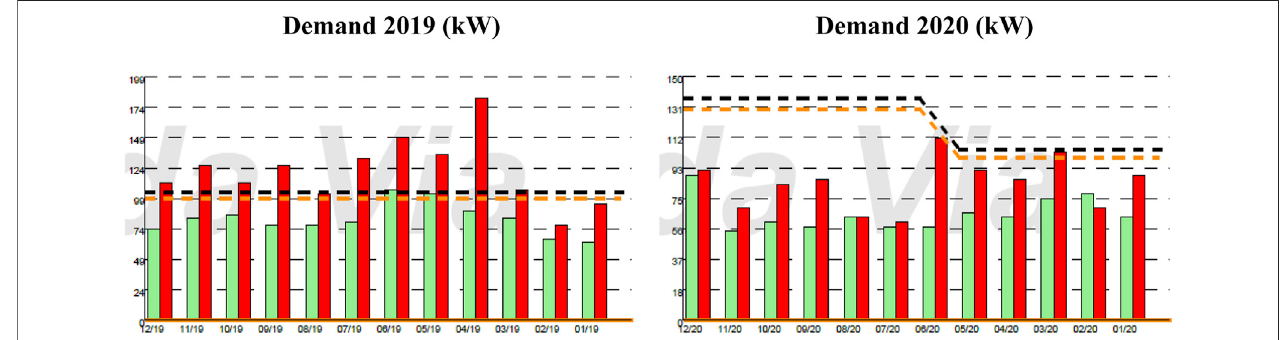
FIGURE 3 | Billed monthly demands and contracted demand limits for 2019 (left) and 2020 (right). Data Sources: Electricity bills for the years 2019 and